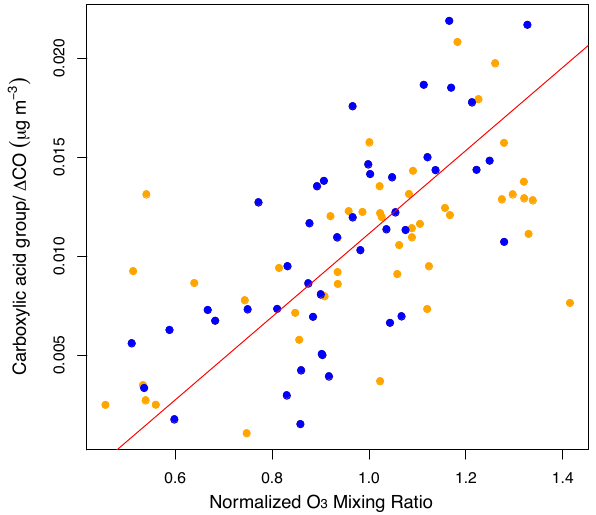
Fig. 10. Correlation of normalized carboxylic acid group concen- Fig. 10. See list of figure captions. 52 tration and normalized O 3 mixing ratio (by campaign average) for the “Afternoon High” (orange) and “Noon High” (blue) days. The correlation coefficient is